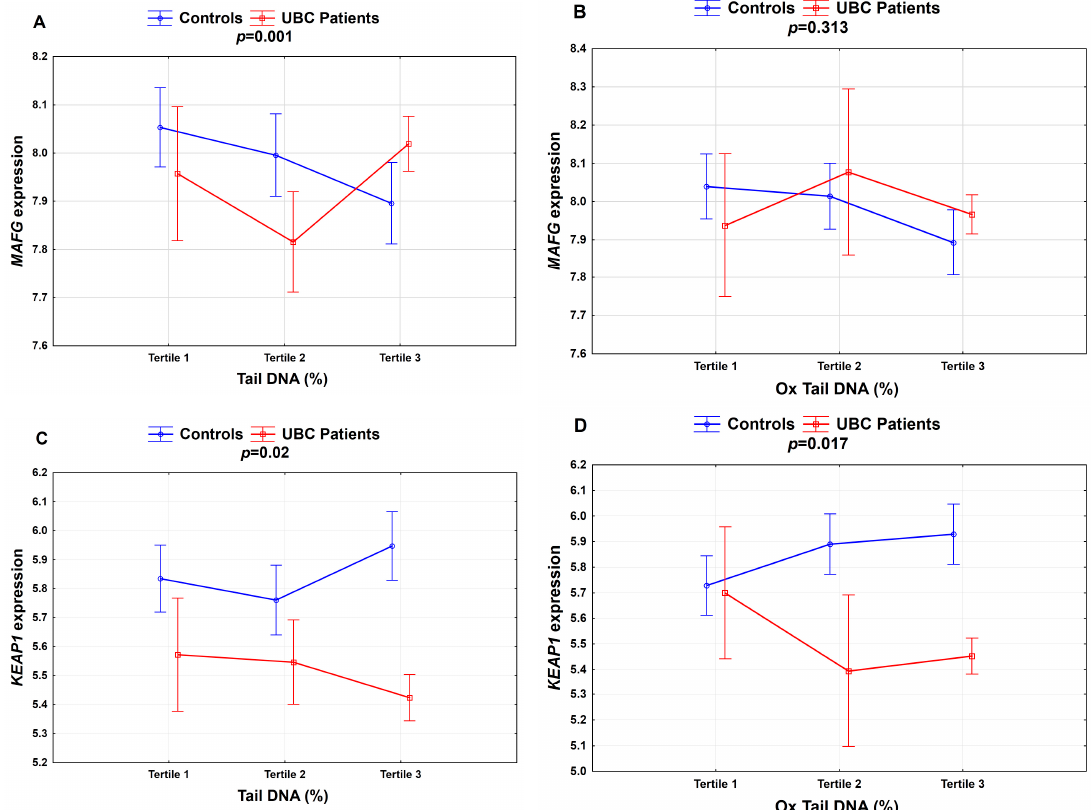
Figure 2. Association between DNA damage and selected cytoprotective gene expression in the study group for ( A ) MAFG ; ( C ) KEAP1 —Tertile 1 ( ≤ 3.74% Tail DNA; N = 7), Tertile 2 (3.75–5.11% Tail DNA; N = 24) and Tertile 3 ( > 5.1% Tail DNA; N = 91); ( B ) MAFG ; and ( D ) KEAP1 —Tertile 1 ( ≤ 6.21% Ox Tail DNA; N = 8), Tertile 2 (6.22–7.37% Ox Tail DNA; N = 6) and Tertile 3 ( > 7.37% Ox Tail DNA; N = 108). p -values were calculated by the two-way ANOVA p < 0.05; the percentages of DNA damage (Tail DNA) and oxidative DNA damage (Ox Tail